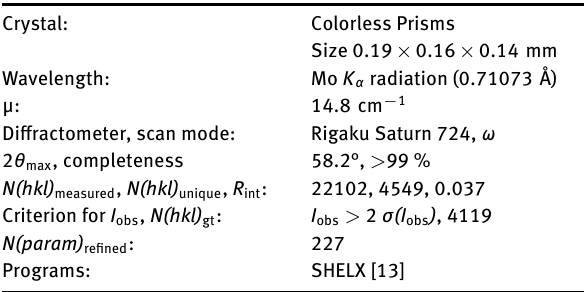
Table 1: Data collection and